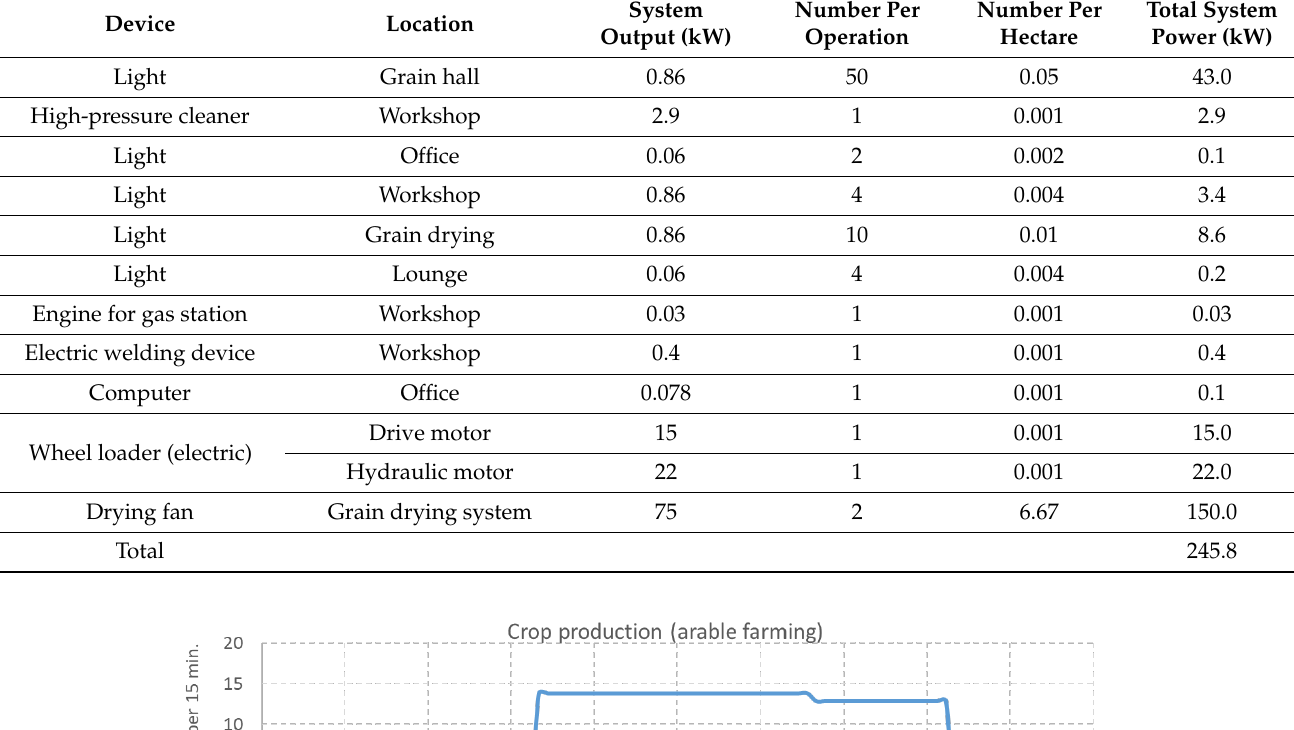
Table 3. Selection of electrical equipment in arable farming (farm size 1000 ha).